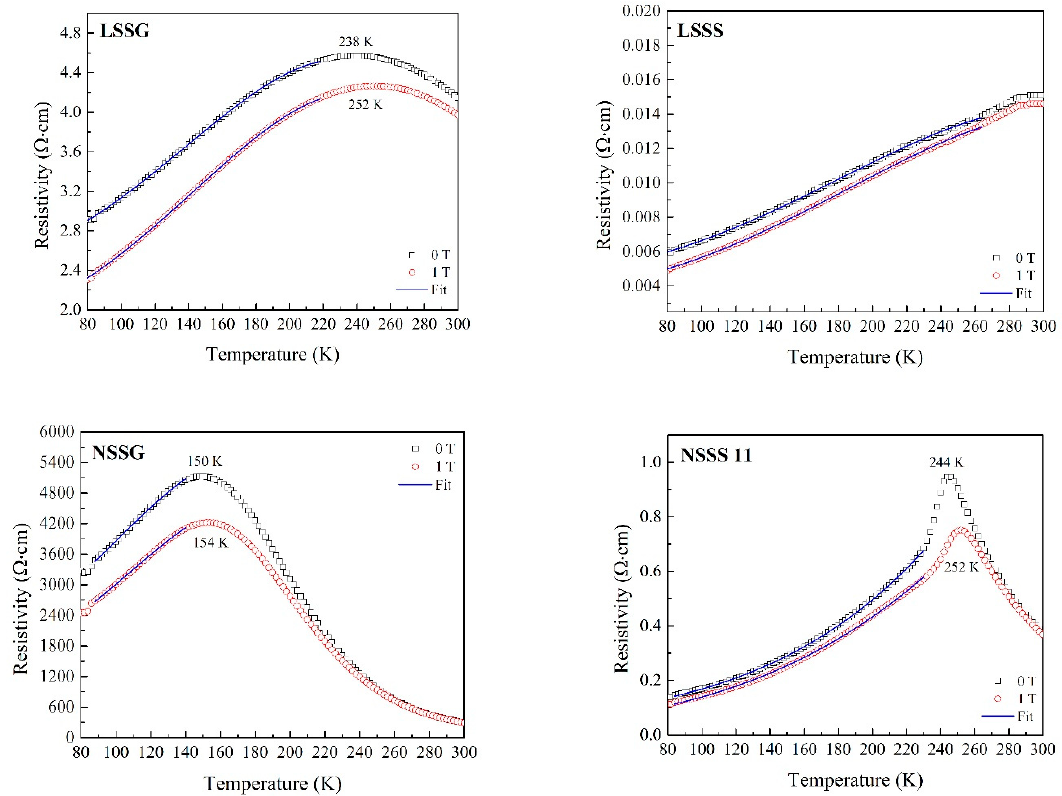
Figure 5. Electrical resistivity as a function of temperature for LSMO and NSMO manganites under applied magnetic field of 0 and 1 T. The solid line represents the best fit of experimental data.